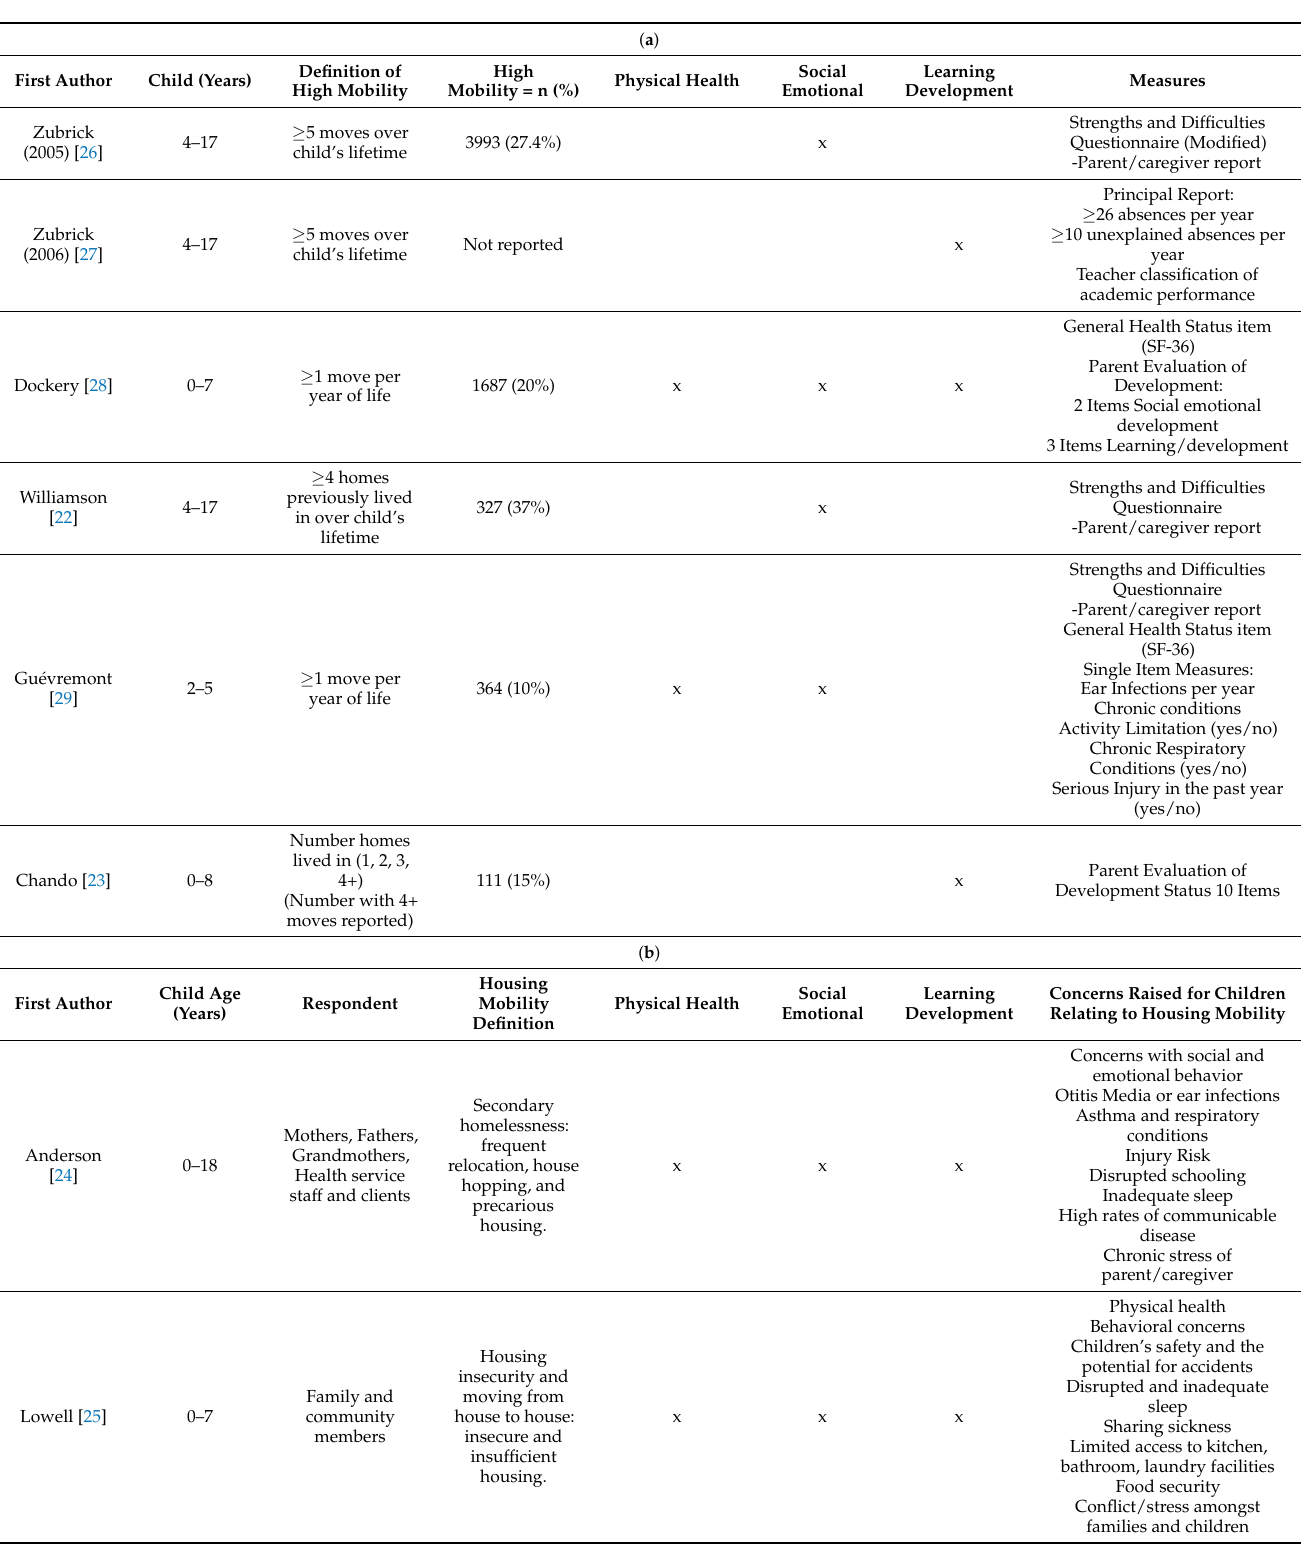
Table 2. ( a ) Definition of mobility and child health outcomes reported in each study (Quantitative). ( b ) Definition of mobility and child health outcomes reported in each study